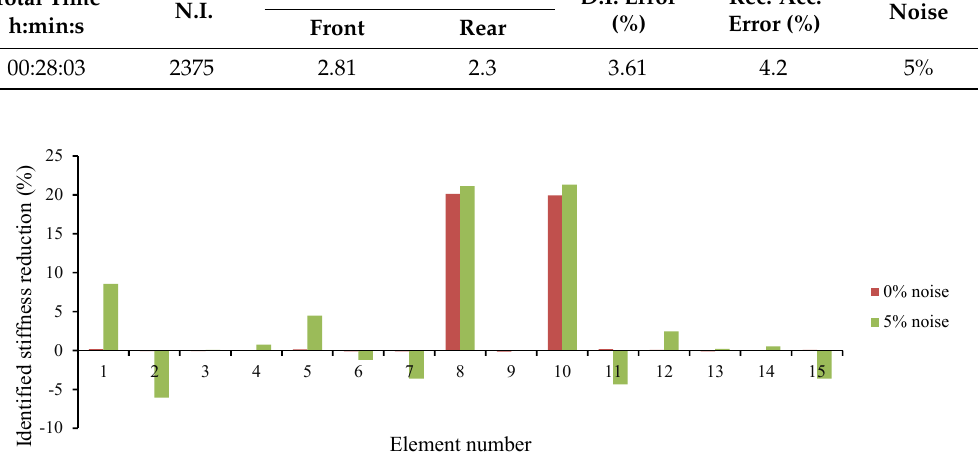
Figure 10. Effect of noise on damage identification of a two-span continuous bridge.